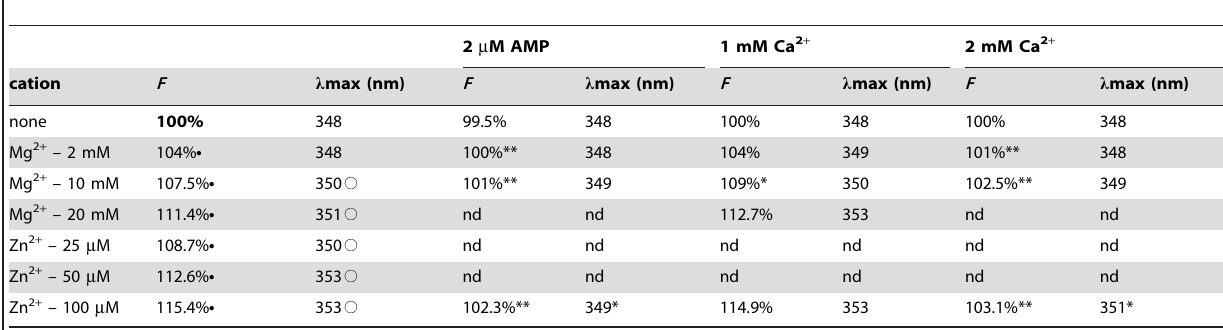
Table 3. Fluorescence emission from ligated complexes of Tyr 57 Trp FBPase.